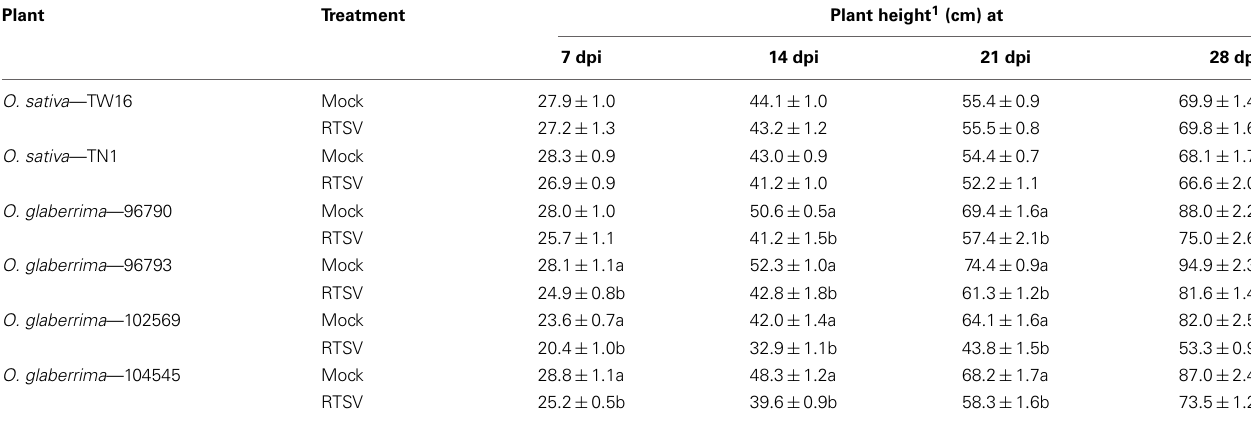
Table 2 | Heights of mock—and Rice tungro spherical virus (RTSV)-inoculated plants of Oryza sativa and O. glaberrima . Plant Treatment